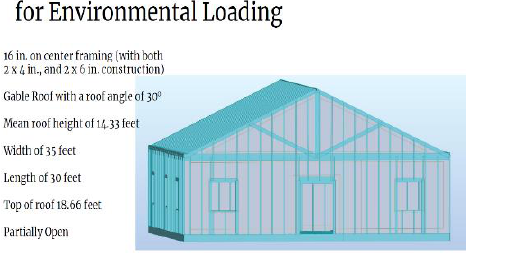
Figure 6. Structure type 5A—single story, no basement ( left panel) and 7A—elevated on open pile ( right panel) based on USACE NACCS classification [7,8]. Details on structure sizes and wood framing are also provided [15].